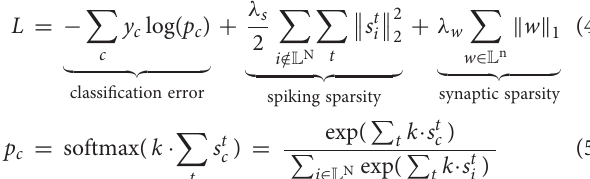
FIGURE 2 | The structure of the SNN layer contains (A) the flat layer with only inter-layer synapses ( w ik ( w ij 0). The corresponding computational graphs are (B,D) , respectively. The legends of arithmetic operations, neuron state variables, and gradients are marked in 6= the lower right corner.